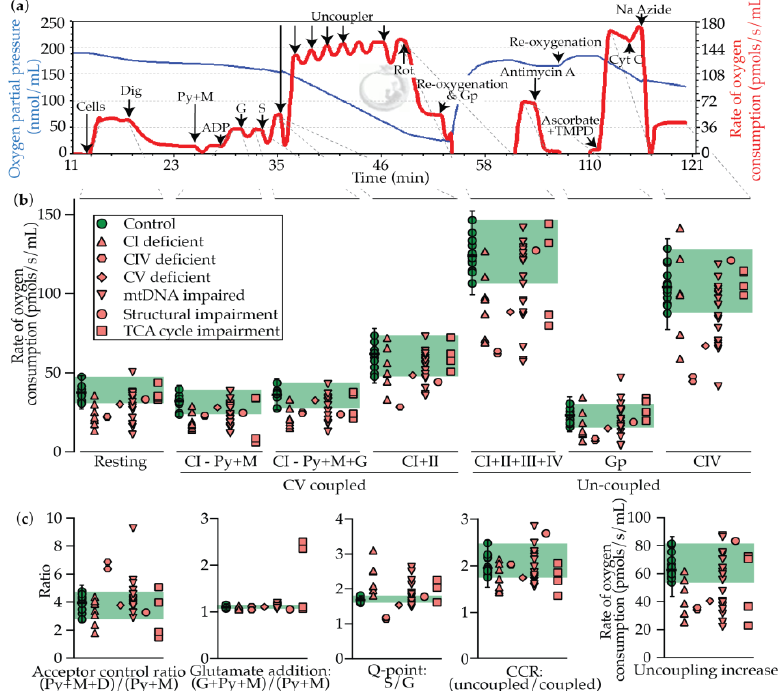
Figure 3. Oxygraphy testing in control and PMD patient fibroblast cells. ( a ) Representative trace from control fibroblasts, with substrates and inhibitors injected as described. Blue line indicates the oxygen partial pressure in the chamber, and the red line indicates the inverted rate of change of the blue line (rate of oxygen consumption). ( b ) Resting, coupled, and uncoupled rates of respiration. ( c ) Ratios and calculated values from data in panel (b). Median is displayed for controls with error bars showing the 1.25 th and 98.75 th percentiles of the reference range, and the green shading region shows the range. Each data point represents the average of each patient or control from ≥ 3 technical replicates.